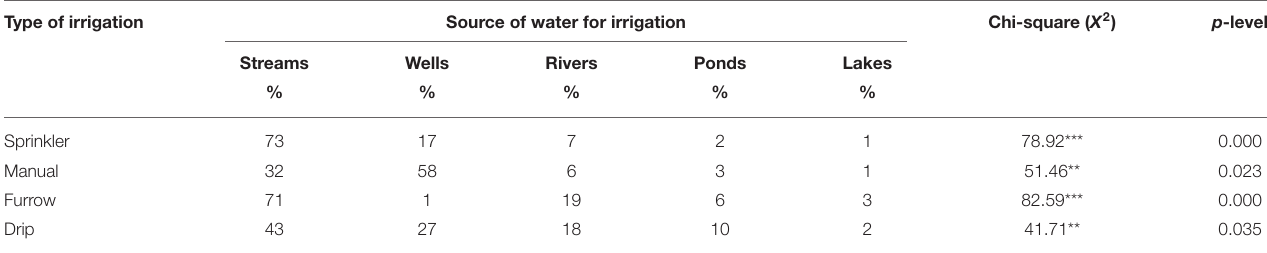
TABLE 3 | Sources of water used for different irrigation practices. Type of irrigation Source of water for irrigation Chi-square ( X 2 ) Streams Wells